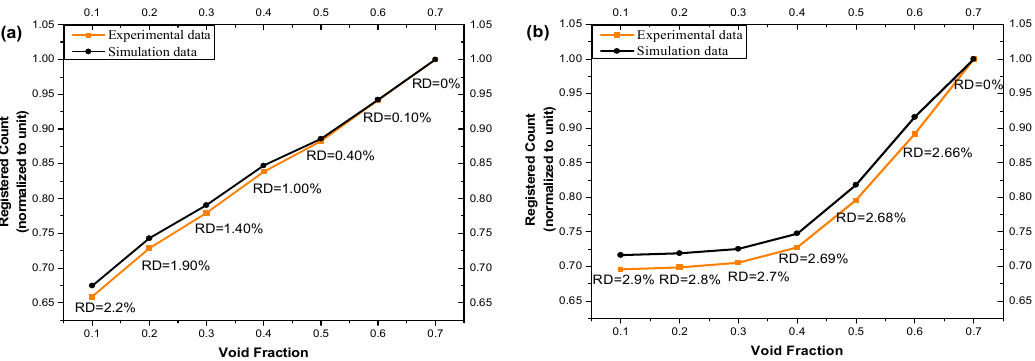
Figure 3. A comparison of experimental and simulation data in an annular regime for responses of ( a ) first transmission detector; ( b ) second transmission detector.